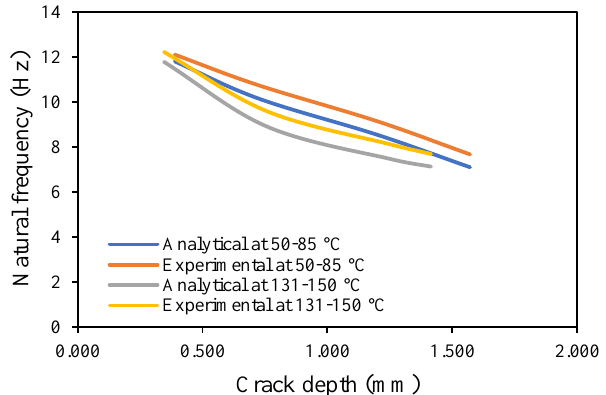
Figure 36. Comparison of the modal amplitude of propagated crack at a non-uniform temperature.